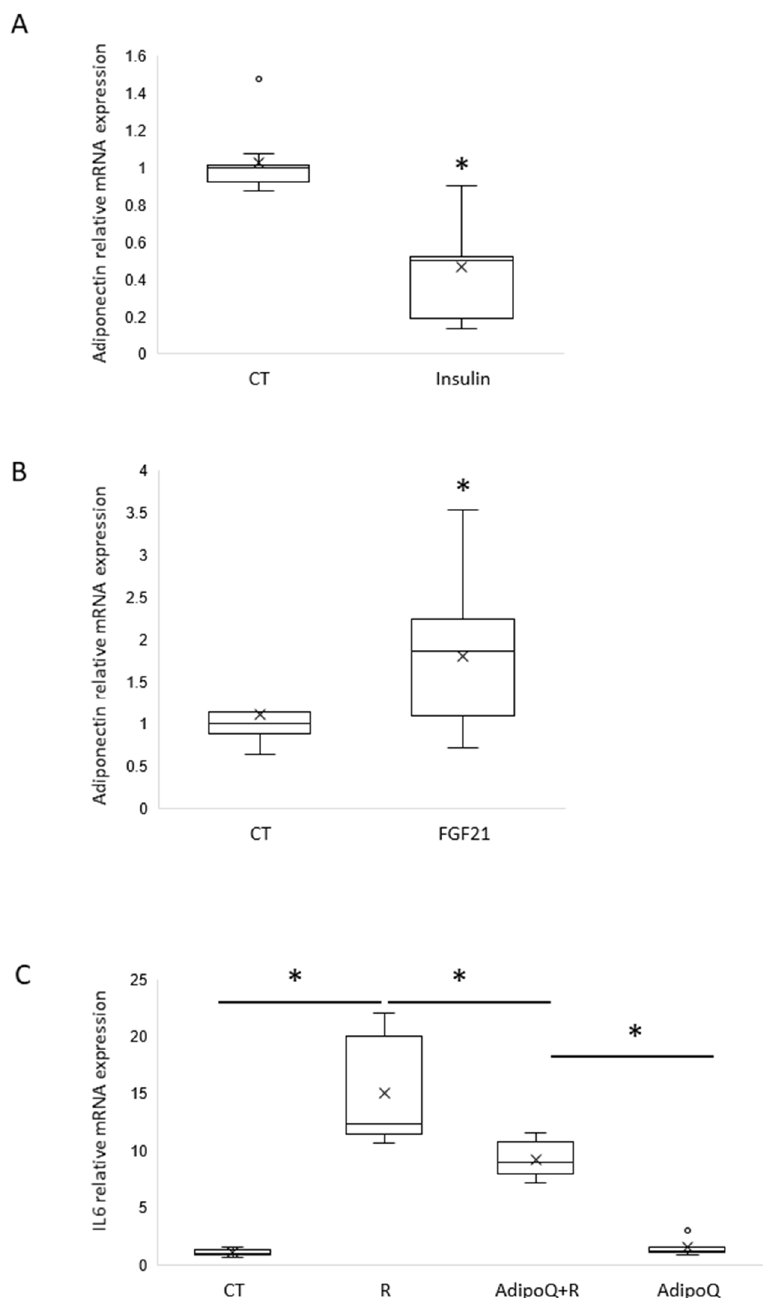
Figure 3. Adiponectin is regulated by insulin and FGF21 in neuronal mHypo-POMC cells and is able to regulate resistin-dependant inflammation in microglial SIMA9 cells. ( A ) Adiponectin mRNA expression normalized on GAPDH obtained by RT-qPCR on mHypo-POMC cells stimulated 16 h with insulin 100 nM, n = 3 experiments in triplicates. ( B ) Adiponectin mRNA expression normalized on GAPDH obtained by RT-qPCR on mHypo-POMC cells stimulated 16 h with FGF21 10 nM, n = 4 experiments in triplicates. ( C ) IL6 mRNA expression normalized on GAPDH obtained by RT-qPCR on SIMA9 microglial cells stimulated with or without resistin 70 ng/mL and with or without adiponectin 1 µ g/mL, n = 3 experiments in triplicates. Results are represented as boxplots showing quartiles (box), median (line), mean (x) and outliers ( ◦ ), * p < 0.05, statistical analyses with non-parametric Mann- Whitney test (2 groups) or two K sample permutation test followed by a two-by-two comparison using nparcomp library in R software (more than 2